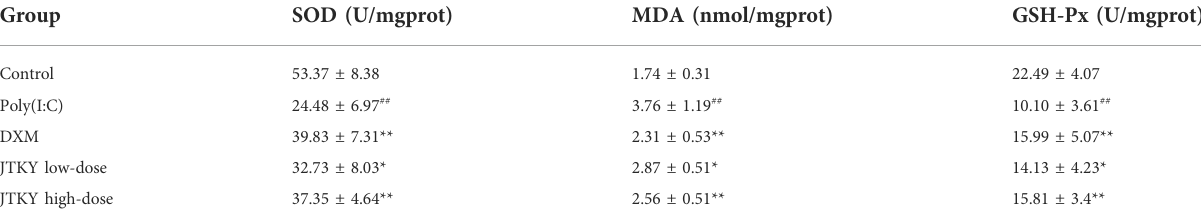
TABLE 4 Effects of JTKY on the activities of SOD and GSH-Px and the level of MDA in lung tissue homogenates.